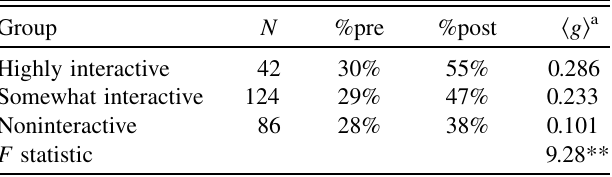
TABLE II. ANOVA of normalized gain scores on CSEM (* p < 0 : 05 , ** p < 0 : 01 ).